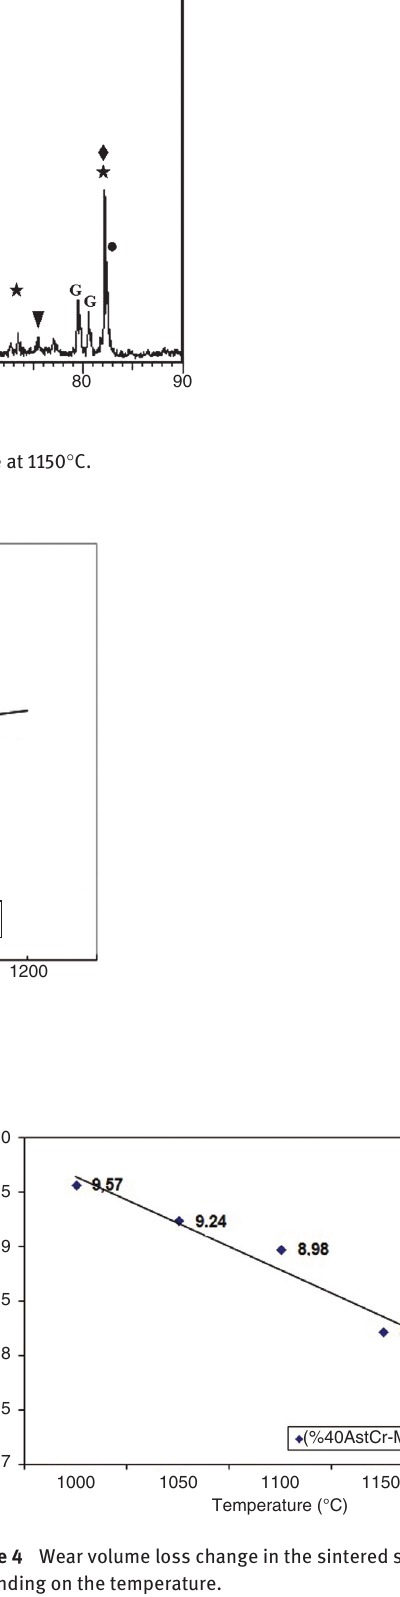
Figure 4 Wear volume loss change in the sintered samples depending on the